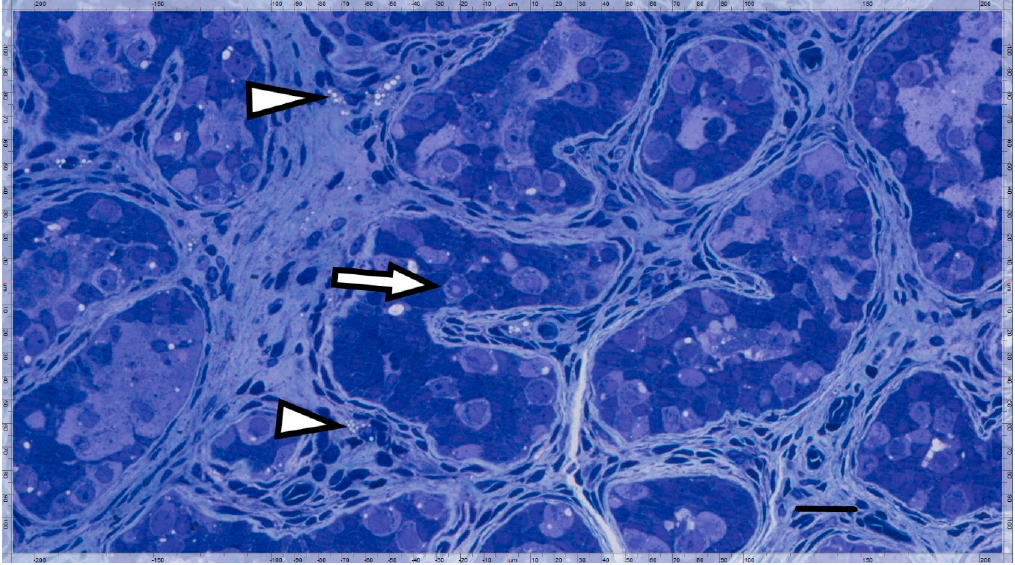
Figure 2. Semi-thin section from a LIR patient’s testis displaying precise testicular structure and Ad spermatogonia with a nuclear rarefaction zone (arrow). Juvenile Leydig cells are atrophic (arrowhead) (horizontal bar; 30 µ).